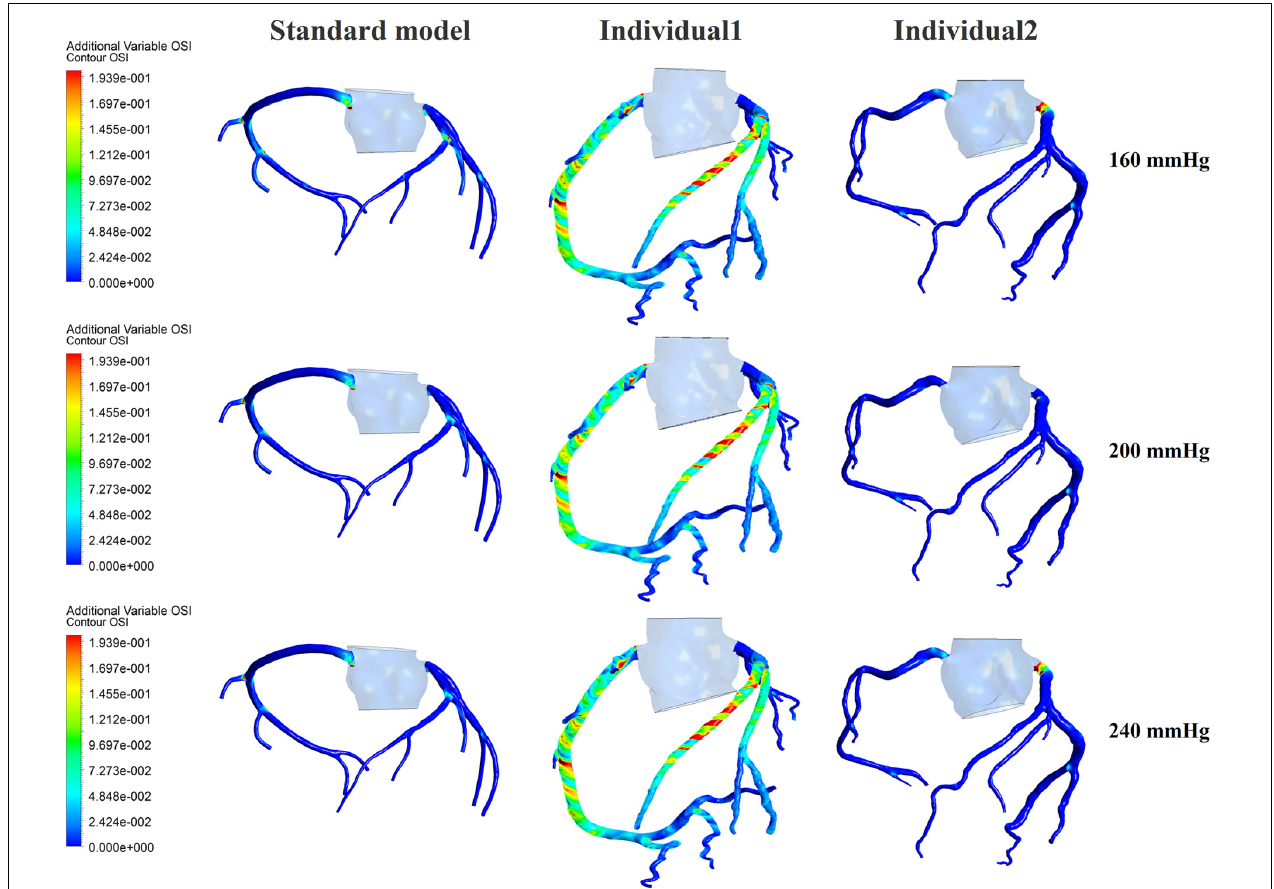
FIGURE 6 | The variations of global OSI of three coronary arteries under different pressure